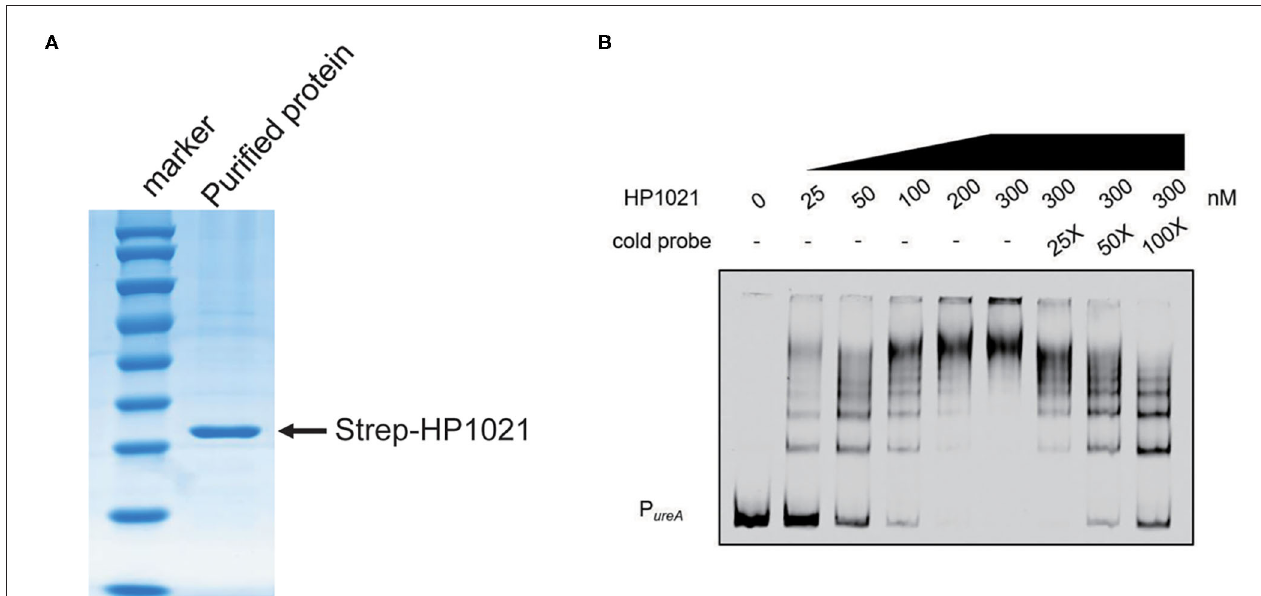
FIGURE 5 | HP1021 bound directly to the ureA promoter region. (A) Coomassie-stained gel of purified Strep-tagged HP1021 protein, indicated by the arrow. (B) Electrophoretic mobility shift assay (EMSA) results of the interaction between HP1021 and the ureAB promoter. Fragments of the 300-bp ureAB promoter region labeled at the 5’-end with AF700 were incubated with increasing concentrations of Strep-HP1021 in the presence or absence of unlabeled ureAB promoter (cold probe). The arrow indicates bands representing 5’ AF700-labeled ureAB probe bound by